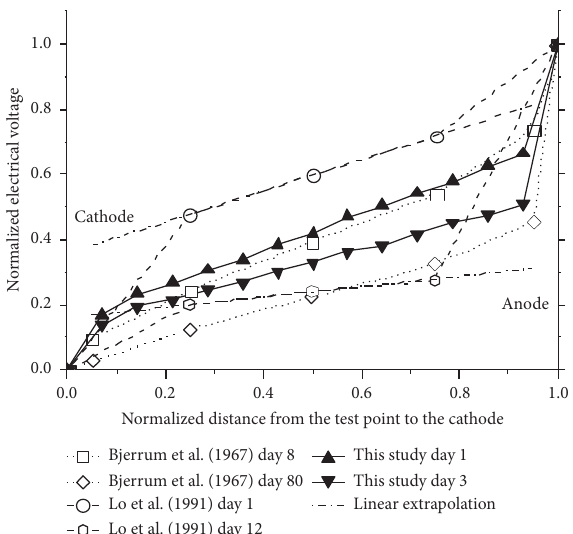
Figure 5: Distribution of voltage between anode and cathode.